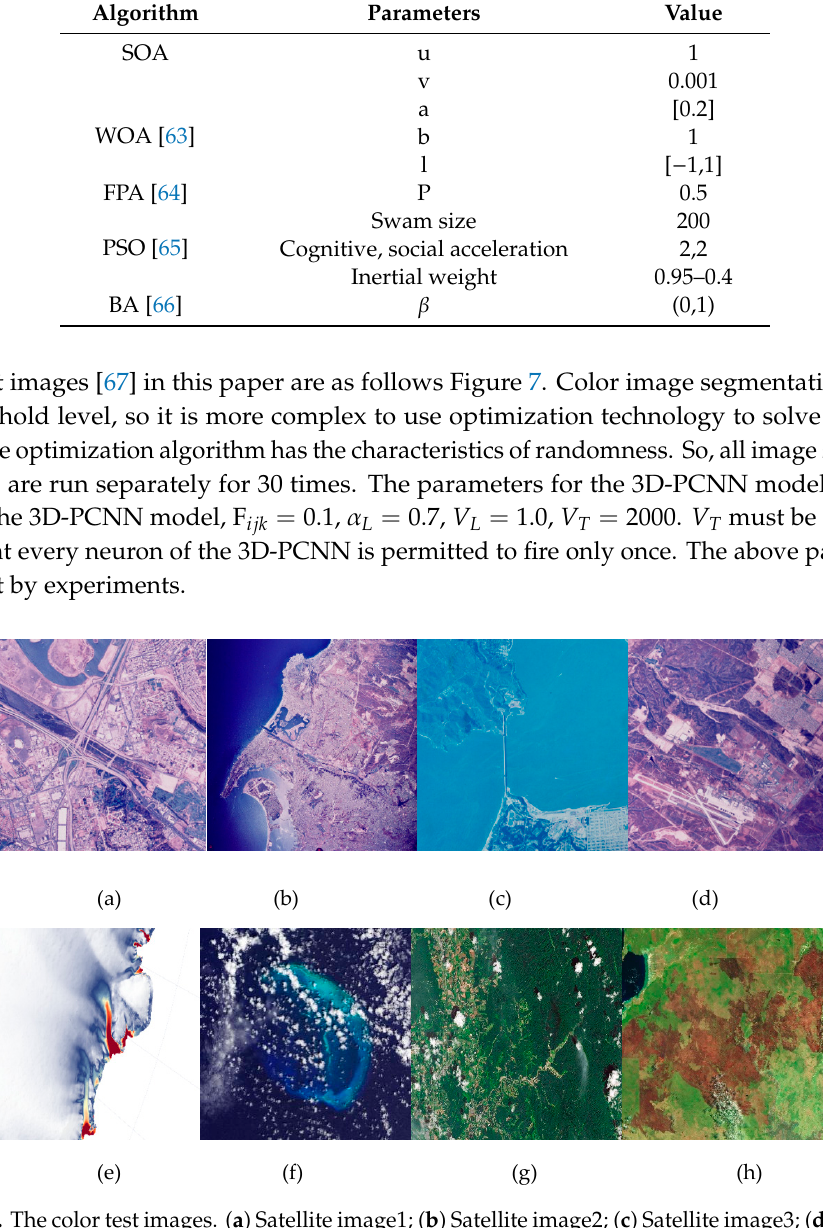
Figure 7. The color test images. ( a ) Satellite image1; ( b ) Satellite image2; ( c ) Satellite image3; ( d ) Satellite image4;( e ) Satellite image5; ( f ) Satellite image6;( g ) Satellite image7; and ( h ) Satellite image8.